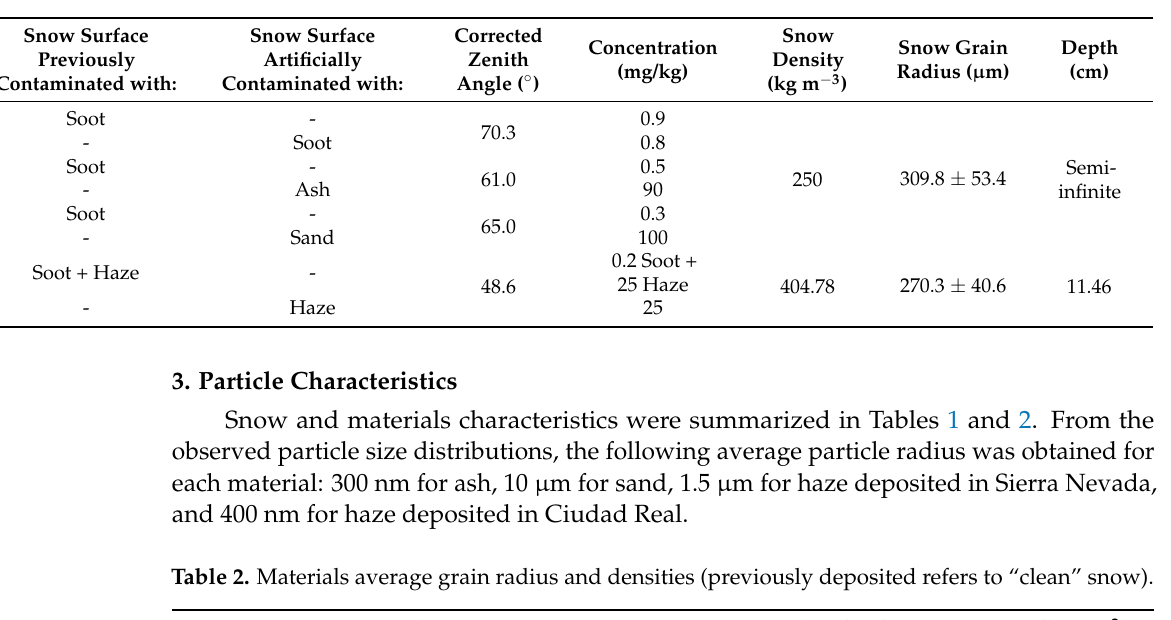
Table 1. Parameters for snow contamination characterisation (previously contaminated refers to “clean” snow).